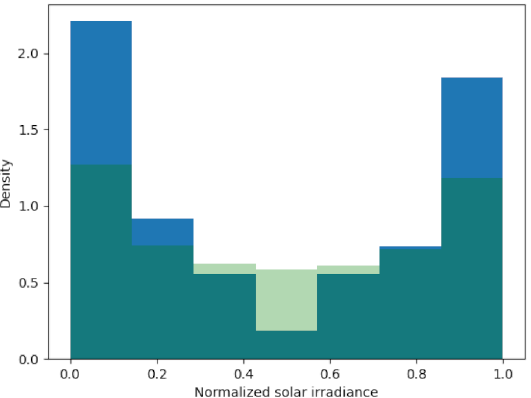
Figure 10. Empirical distribution (blue bars) and beta distribution fitting solar irradiance data of 9:00 of all days of January 2018 and 2019 (excluding anomalous data) using seven regions (green bars overlaid in transparency).